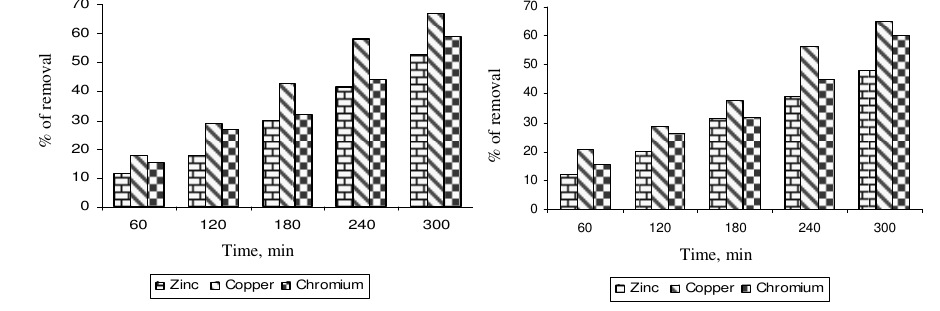
Figure 5. Effect of contact time on the removal of Zn(II), Cu(II) and Cr(VI) by sawdust. Condition: T = 23 o C